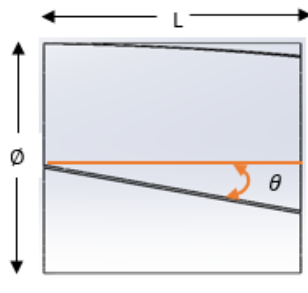
Figure 5. Design of GVD.